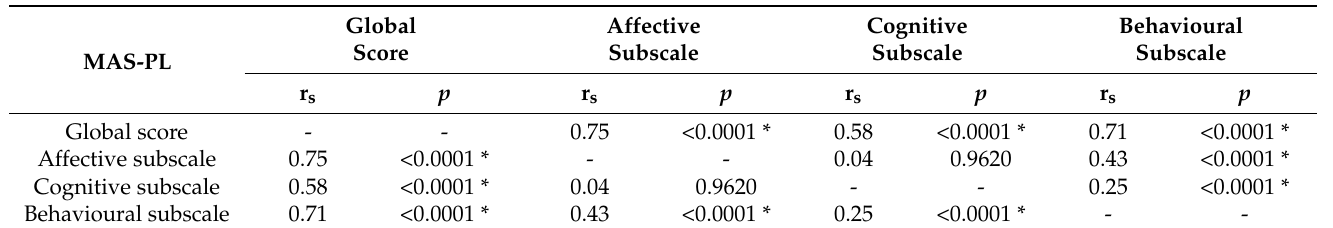
Table 4. Relationships between the results of the individual subscales and the global MAS-PL scale.